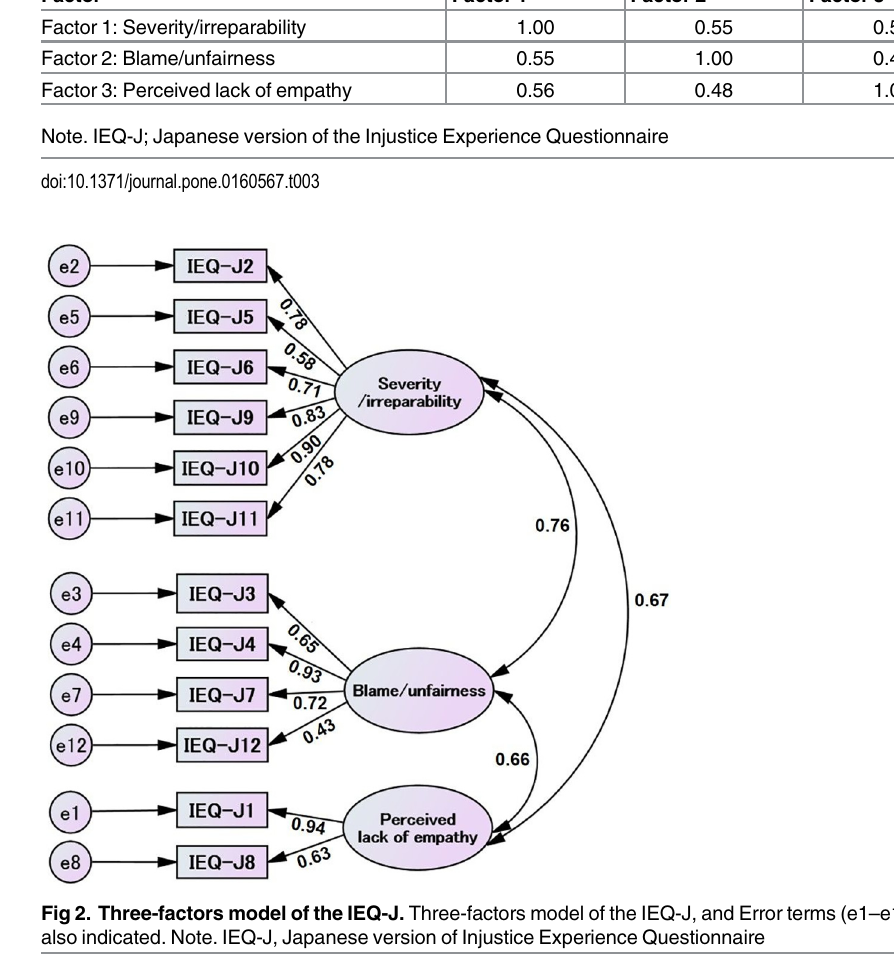
the IEQ-J [25]. Whereas the three models ’ SRMRs range was 0.09 or lower, indicating a good fit [26], the SRMR of model 3 (0.063), was better than that of model 1 (0.085), and of model 2 (0.084). Furthermore, the CFI (0.98) and TLI of Model 3 (0.97) were recognized as a good fit (around 0.95) [26].